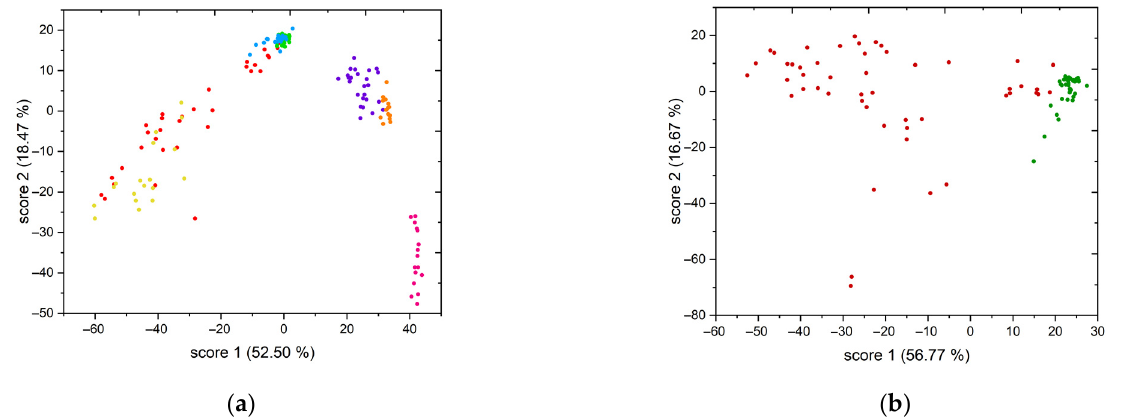
Figure 7. ( a ) Score plot of PCA of all samples analyzed with LIBS on the handheld spectrometer (red—Cypriot mine 1, yellow—Cypriot mine 2, green—Cu 2 S in basalt, blue—CuFeS 2 in basalt, purple—Polish mine, orange—Cu 2 S in schist, pink—CuFeS 2 in schist). ( b ) Score plot of PCA of Cyprian samples (dark red) and samples containing Cu 2 S and CuFeS 2 in basalt (dark green). The PCA of the samples analyzed by the Echelle spectrometer yields a better cluster separation of the different sources (Figure 8). Similar to the score plot of the handheld spectrometer, the basalt containing samples (Cyprian mine 1 (red), Cyprian mine 2 (yellow), Cu 2 S (green) and CuFeS 2 (blue) in basalt) are spatially separated from the schist containing samples (Polish mine (purple), Cu 2 S (orange) and CuFeS 2 (pink) in schist). The clusters are more clearly separated from each other than in Figure 7a, which is also reflected in